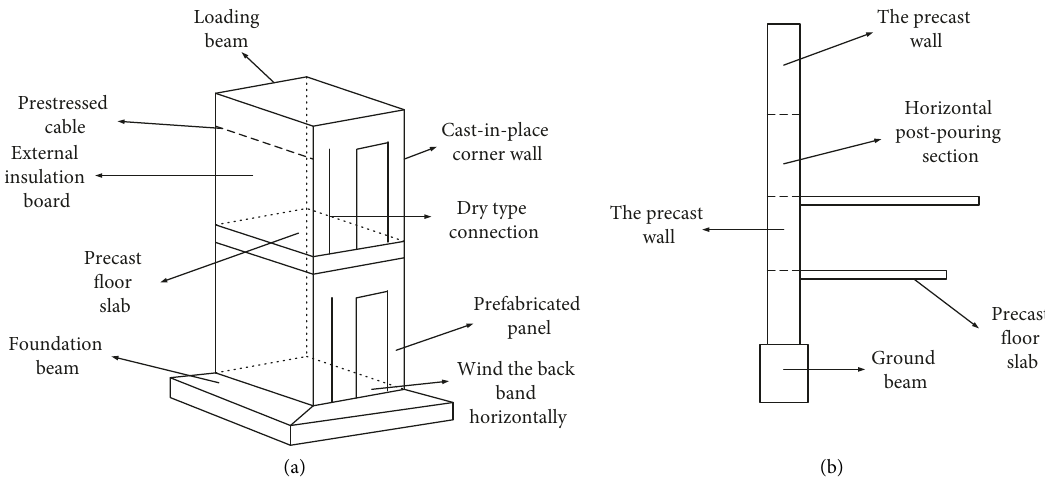
Figure 3: Shear wall structure: (a) fabricated shear wall integral structure and (b) shear wall